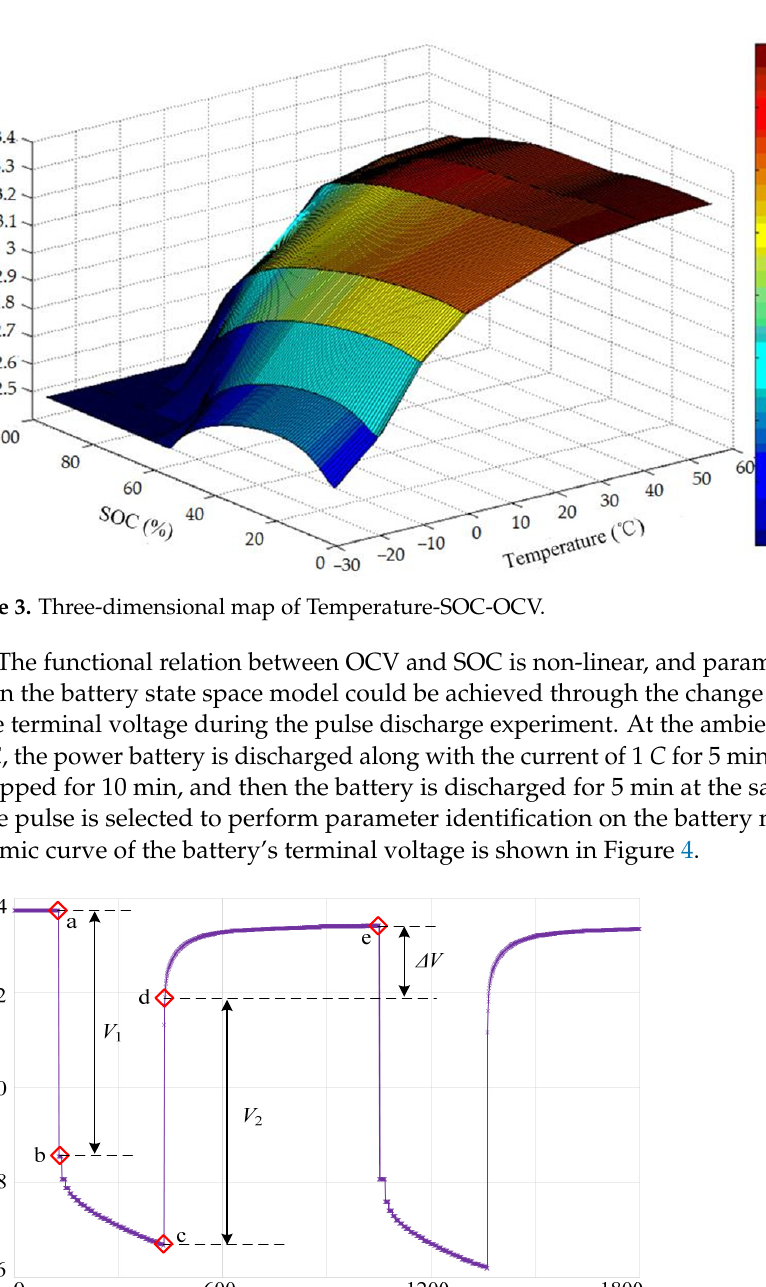
(6) where K i ( i = 0, 1, 2, …) is in reference to the specific ambient temperature, it influences the accuracy of the characteristic polynomial, which could be derived through the experimental pulse discharge results. The derived values of K i under the various ambient temperatures are displayed in Table 2. Based on the sixth-order polynomial, a three-dimensional 3 correspondingly. Table 2. Coefficient values under different operating temperatures. Coefficient